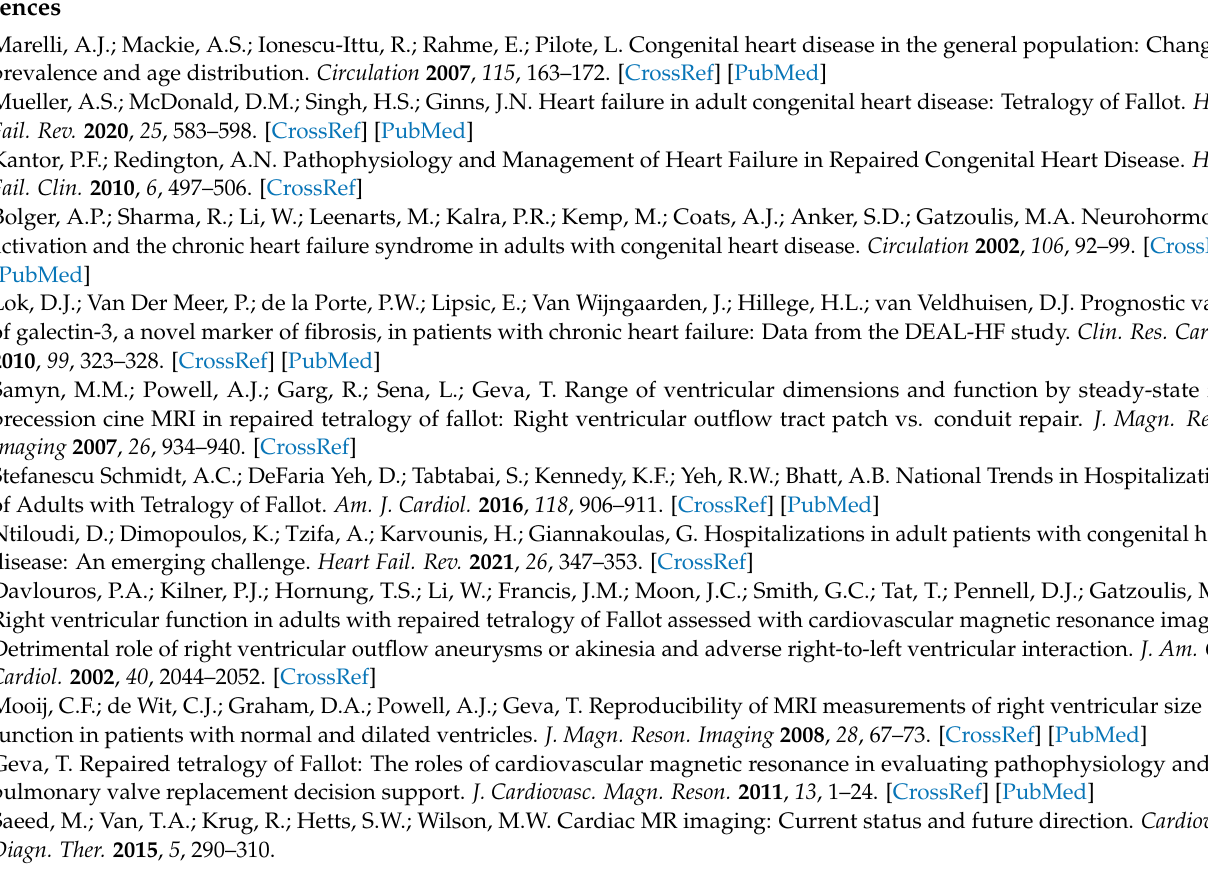
LGE RV scores, Figure S2: Frequency of LGE RV detection according to the segmentation system of RV (%), Figure S3: Effect of LGE RV extent and severity of PR in RVEF% in adults with rToF, Table S2: Relations of Biomarkers levels with the severity of residual